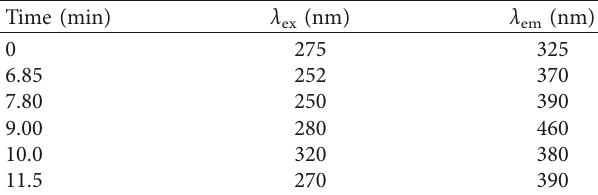
Table 1: The fluorescence detection wavelengths for